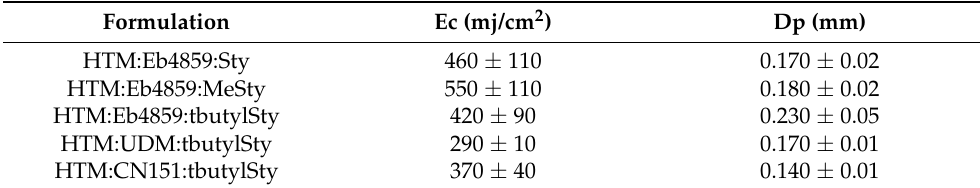
Table 5. Working curve data for HTM ternary 3D printed formulations.